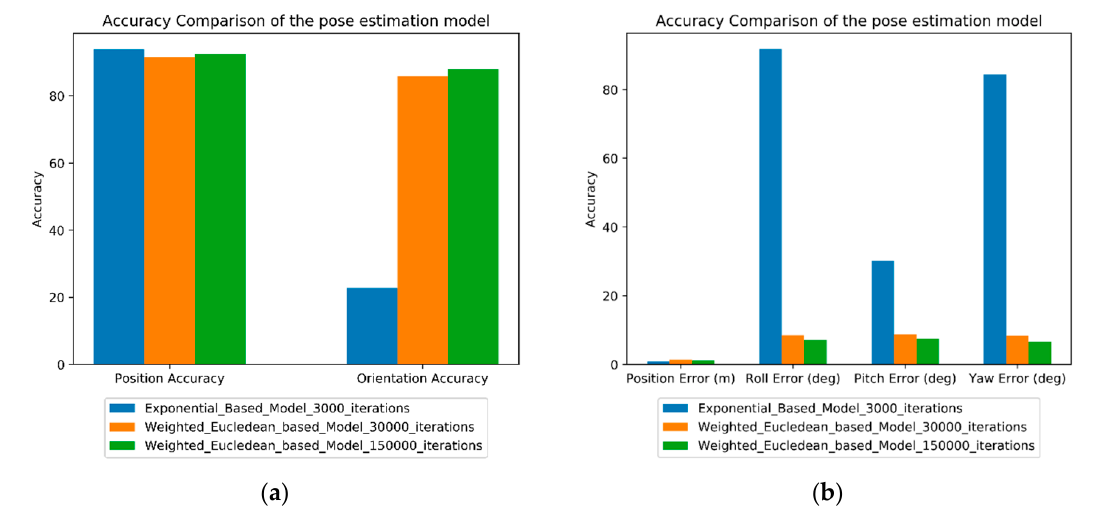
Figure 11. Comparison of the exponential-based pose estimation model and the weighted Euclidean- Comparison of the exponential-based pose estimation model and the weighted based pose estimation model: ( a ) Accuracy comparison and ( b ) error comparison. Euclidean-based pose estimation model: ( a ) Accuracy comparison and ( b ) error